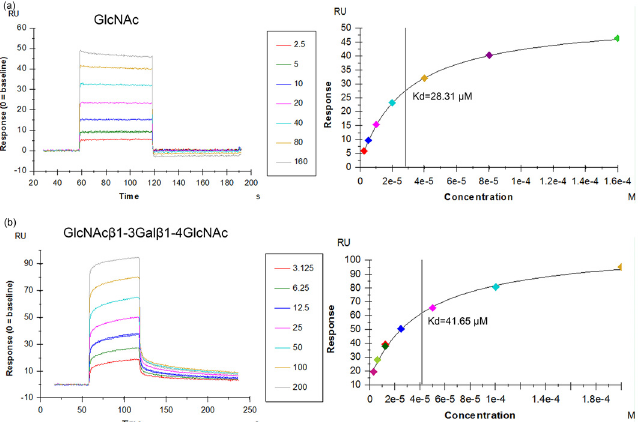
Fig 1. SPR analysis of binding of GlcNAc and GlcNAc β 1-3Gal β 1-4GlcNAc to immobilized AAL2 at 298 K. (a) The binding curves measured at different concentrations of GlcNAc and the steady state affinity indicated by the value of Kd. (b) The binding curves measured at different concentrations of GlcNAc β 1- 3Gal β 1-4GlcNAc and the steady state analysis shows that the affinity of AAL2 to the trisaccharide is close to but a little lower than that to